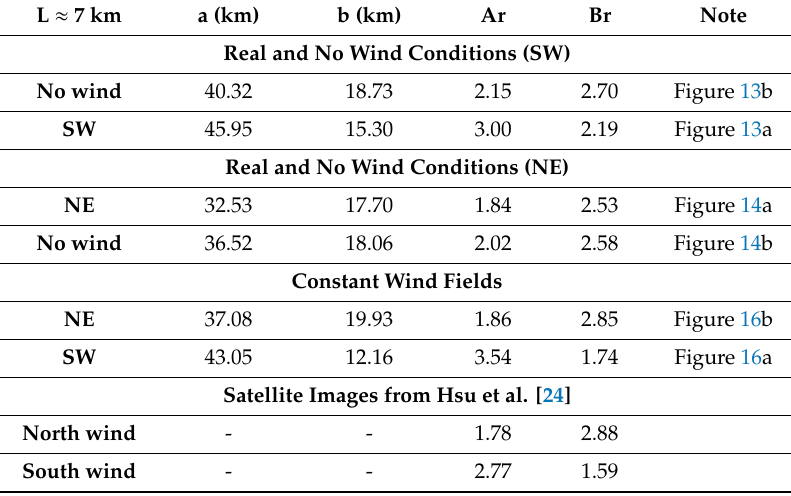
Table 3. Characteristics of Green Island vortex